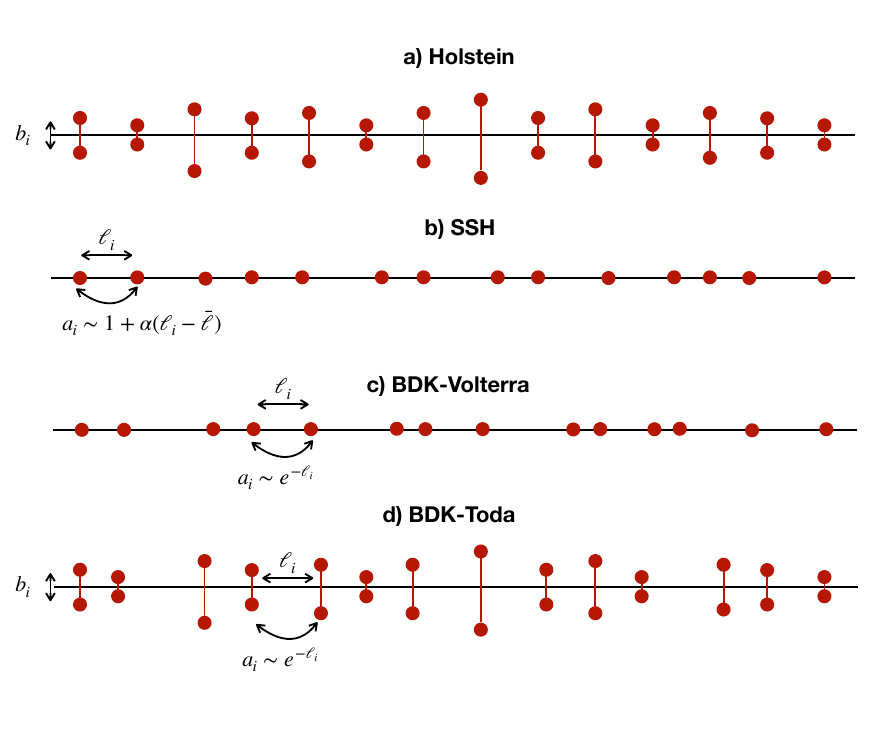
Figure 1: Illustration of the different models discussed in the